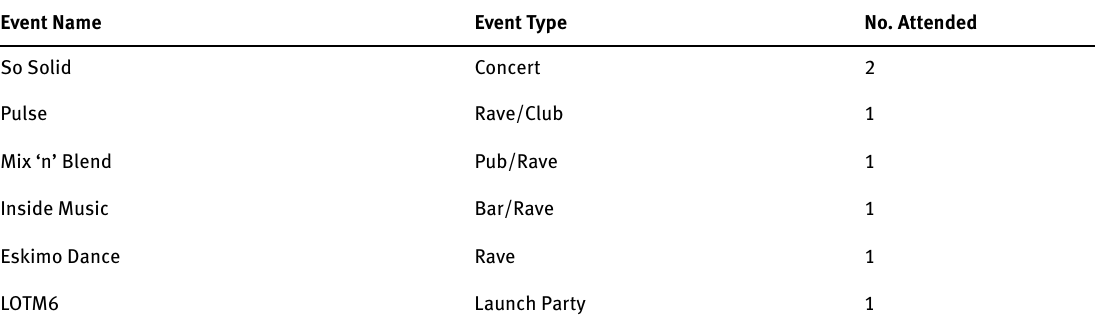
Table 1. Events attended and online